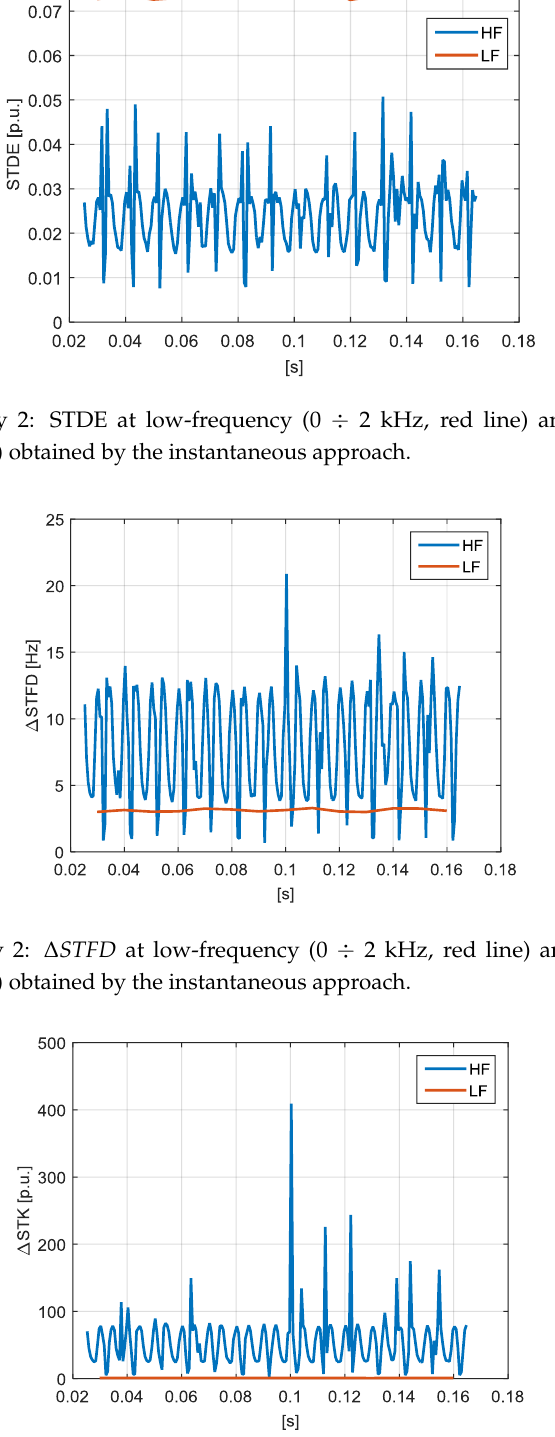
Figure 15. Case study 2: STDE at low-frequency (0 ÷ 2 kHz, red line) and at high-frequency (2 ÷ 150 kHz, blue line) obtained by the late approach. Figure 16. Case study 2: Δ STFD at low-frequency (0 ÷ 2 kHz, red line) and at high-frequency (2 ÷ 150 kHz, blue line) obtained by the late approach.